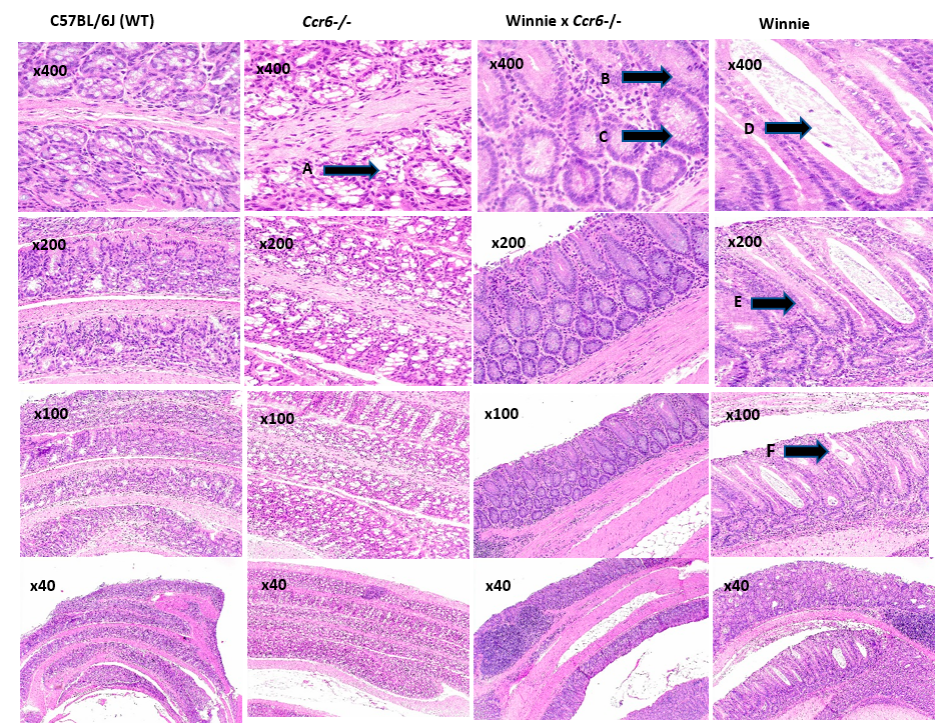
Figure 3. Representative images of H&E colon histomorphologyin C57BL/6J, Ccr6 − / − , Winnie × Ccr6 − / − , and Winnie at 16–22 weeks of age. Arrows indicate ( A ) mucus filled goblet cells inside short crypts in Ccr6 − / − , ( B ) moderately elongated crypts in Winnie × Ccr6 − / − , ( C ) mucus filled goblet cells in Winnie × Ccr6 − / − , ( D ) crypt abscess in Winnie, ( E ) highly elongated crypts in Winnie, ( F ) mucosal ulcerations in Winnie. Inflammation in the colon was evaluated using histological scheme where a score of 0–5 was used. No inflammation in WT and Ccr6 − / − (histological score = 0) while moderate inflammation existed in Winnie × Ccr6 − / − (histological score = 2) Severe inflammation was evident in Winnie (histological score=5). Magnification ×40, ×100, ×200 and ×400.